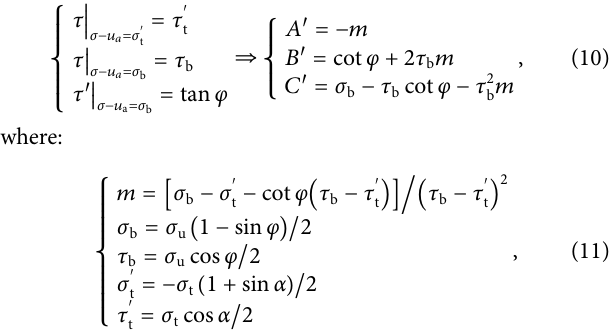
Frontiers in Earth Science |